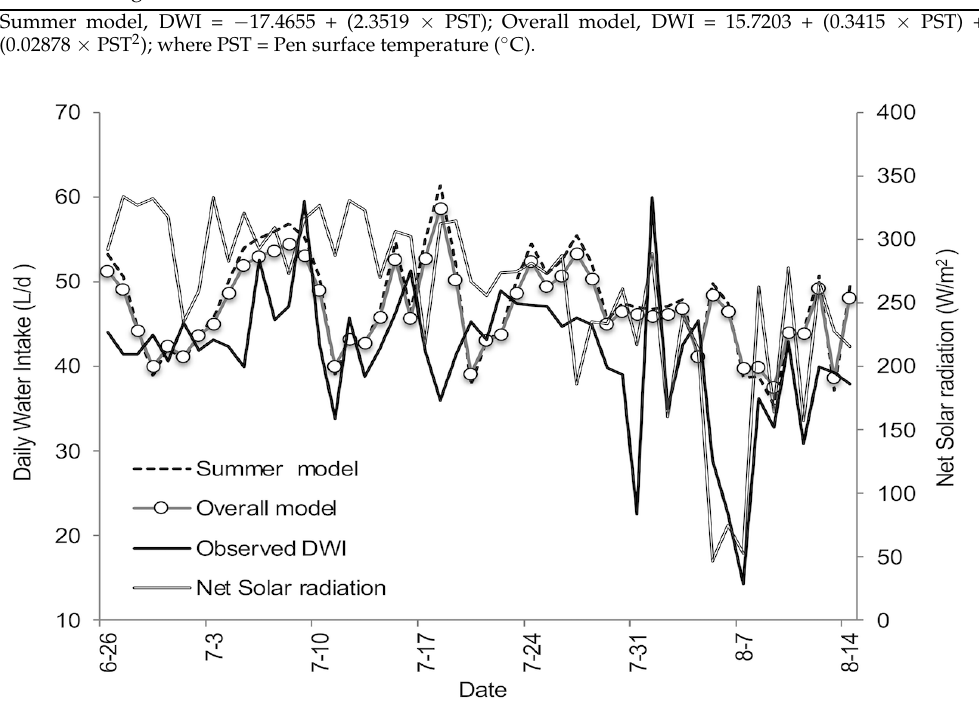
Figure 4. Observed and predicted daily water intake (DWI) using the pen surface temperature as the predictor variable in both models (overall and summer) for the period 27 June to 15 August 2007. Table 4. Adjusted coefficients of determination for regression equations and correlation values for observed daily water intake and net solar radiation in finishing steers with the validation